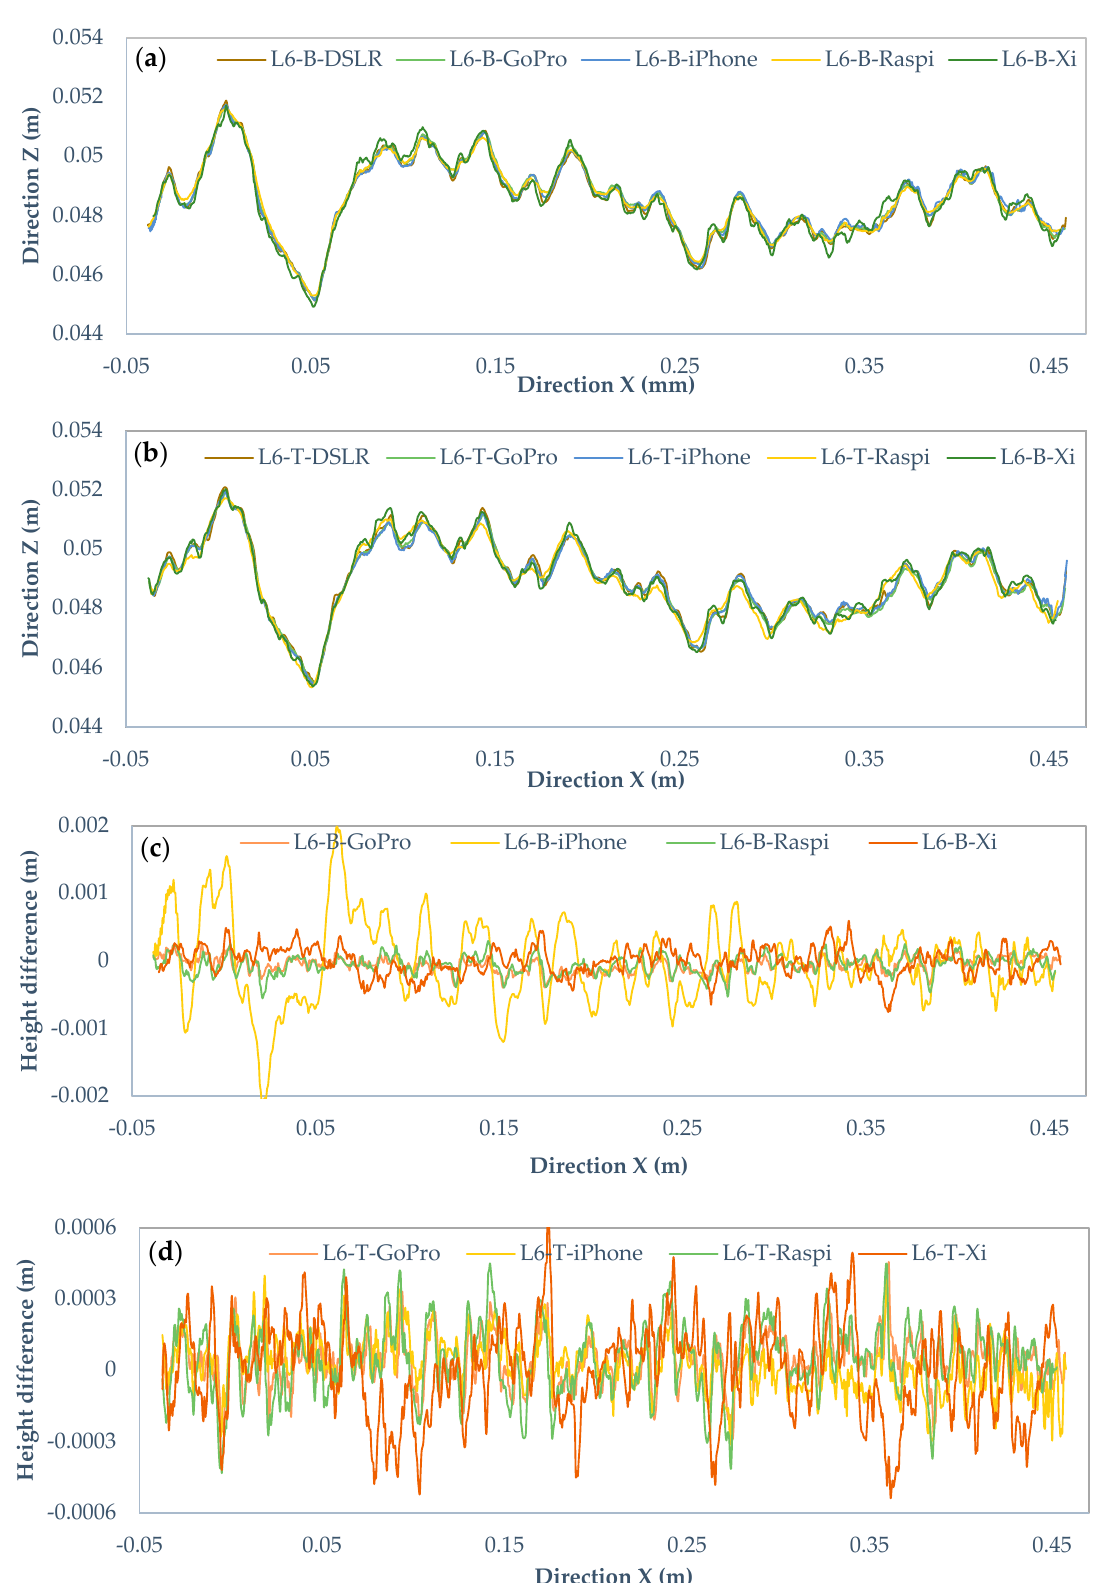
Figure 14. Comparison of the Canon EOS 5DS R DSLR and low ‐ cost camera profiles with 0.25 mm rasterization grid interval. ( a ) Original profiles of bottom surface, ( b ) top surface, ( c ) height differ ‐ ences of bottom profiles, and ( d ) top profiles.